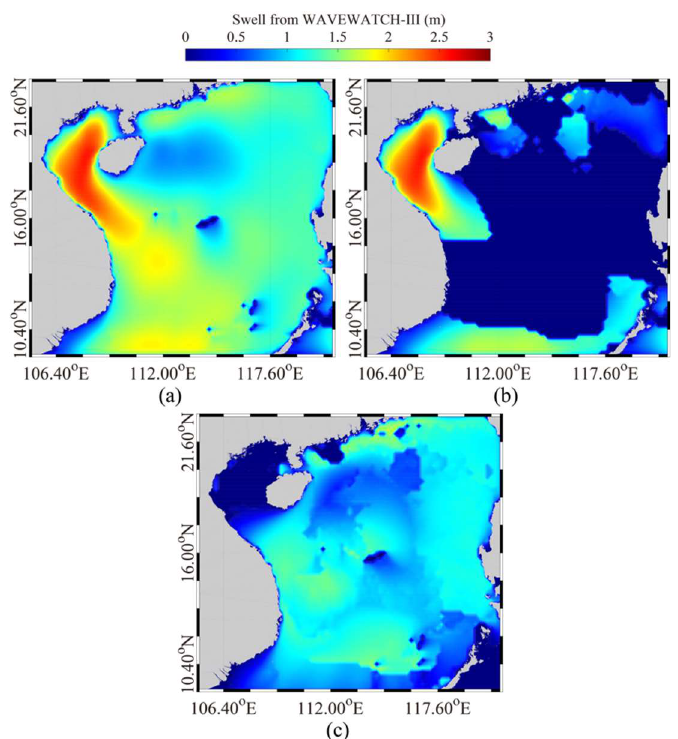
Figure 11. The distribution of wave at 6:00 a.m. UTC on 16 September 2017 during Typhoon Khanun. ( a ) the distribution of total SWH; ( b ) the distribution of wind-sea portion; ( c ) the distribution of swell portion.